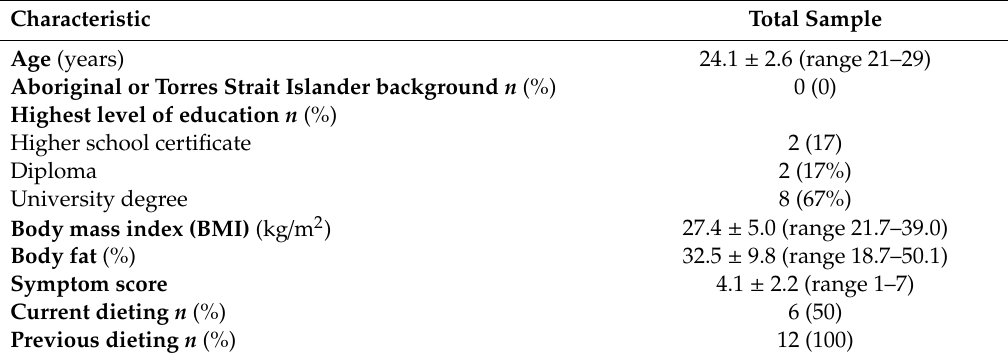
Table 1. Participant characteristics at baseline ( n =